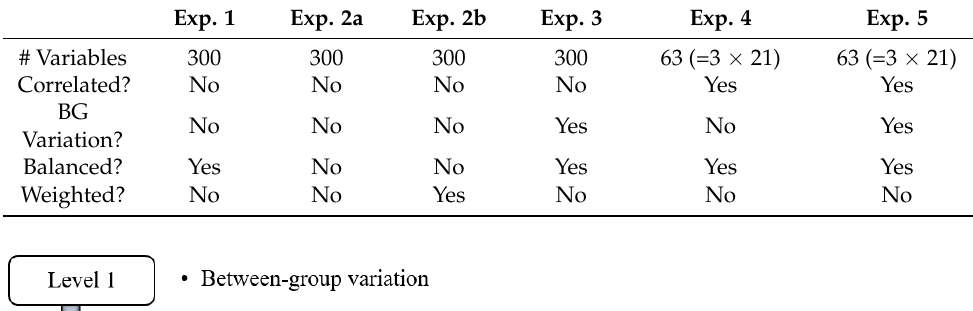
Table 1. Overview of all MC simulations carried out here. Experiments 1 to 3 use uncorrelated normally distributed variables, whereas Experiments 4 and 5 use correlated normally distributed data inspired by 21 3D landmark points (thus 63 variables), as shown in Figure 1. (# Variables = number of variables; Correlated? = whether or not these variables are correlated or uncorrelated; BG Variation? = whether or not between-group variation is used in data generation; Balanced? = whether or not sample sizes are equal in all groups; Weighted? = whether or not weighted covariance matrices of Equations (7) and (8) are used).